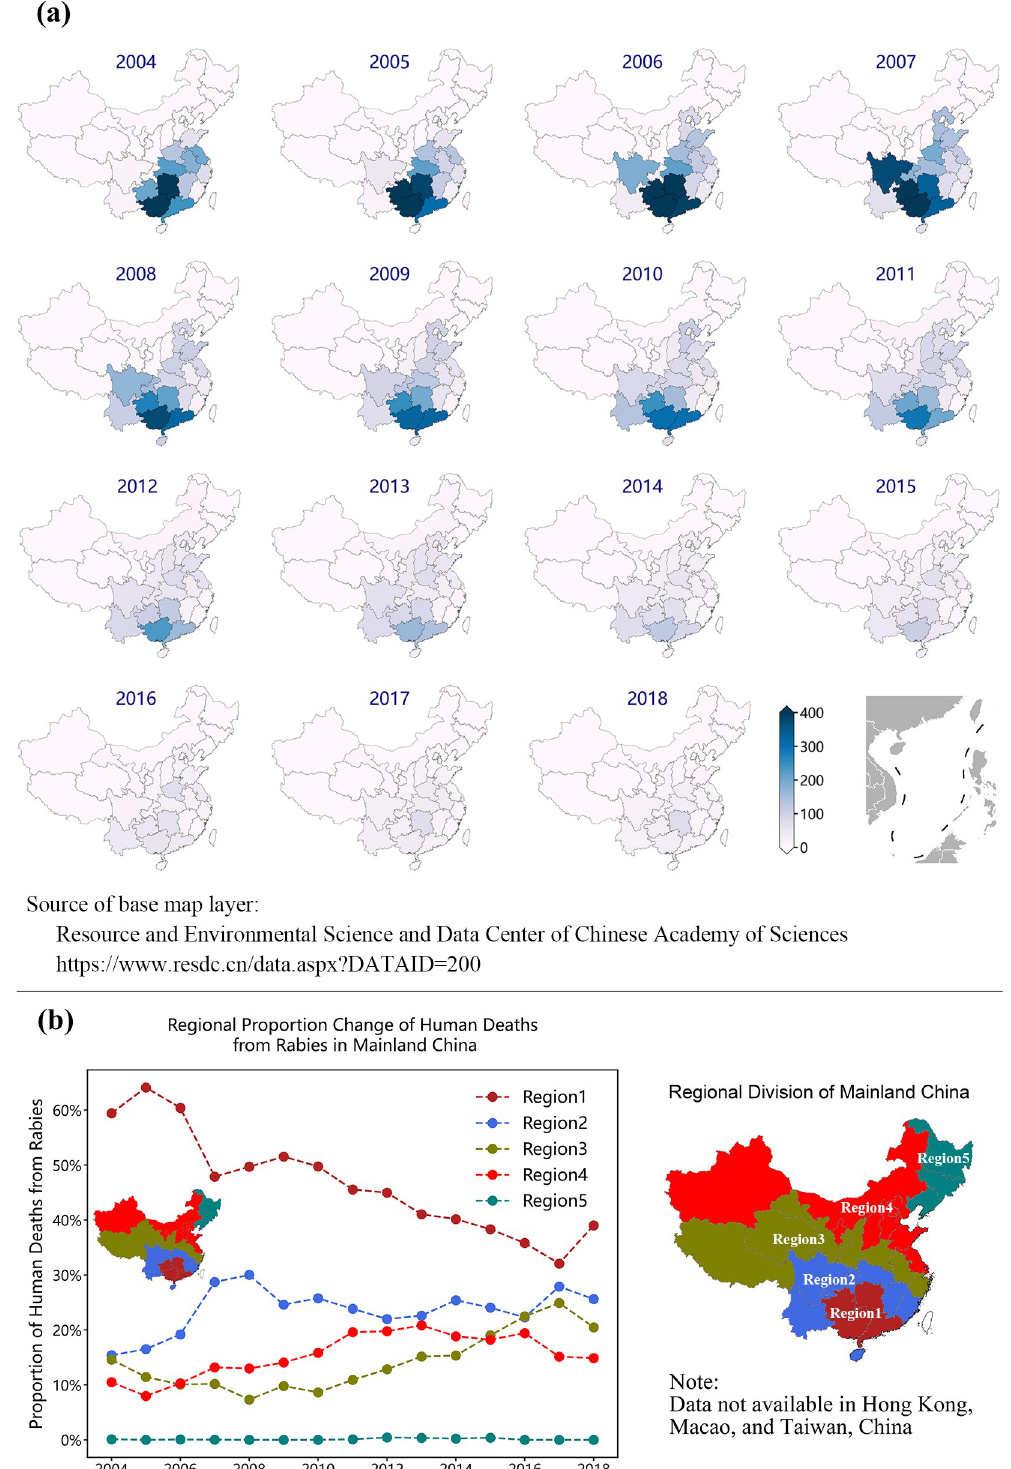
Fig 3. The regional distribution of human deaths from rabies in mainland China. (a) The annual human deaths from rabies in different states and territories from 2004 to 2018 in mainland China. (b) The proportion change of the human deaths from rabies in various regions from 2004 to 2018 in mainland China. Source of the base map layer: Resource and environmental science and data center of Chinese Academy of Sciences, https://www.resdc.cn/data.aspx?DATAID=200.